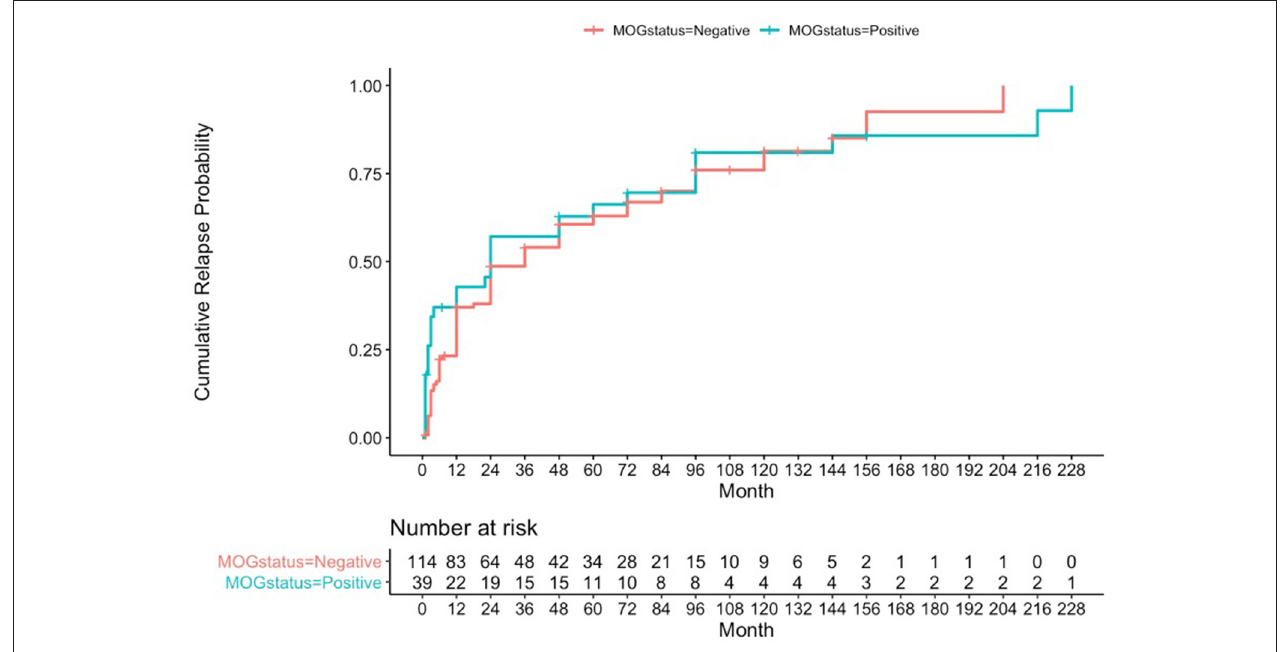
FIGURE 1 | Kaplan-Meier analysis for cumulative relapse probabilities in the MOG-antibody positive and AQP4- and MOG-antibody seronegative groups.